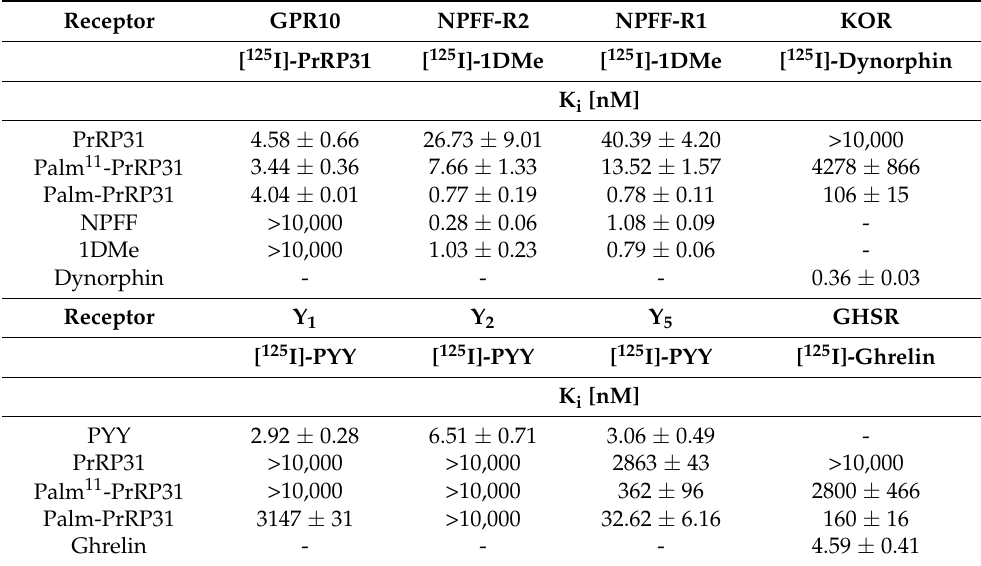
Table 2. Binding affinities of natural PrRP31, its analogs and other peptides to tested